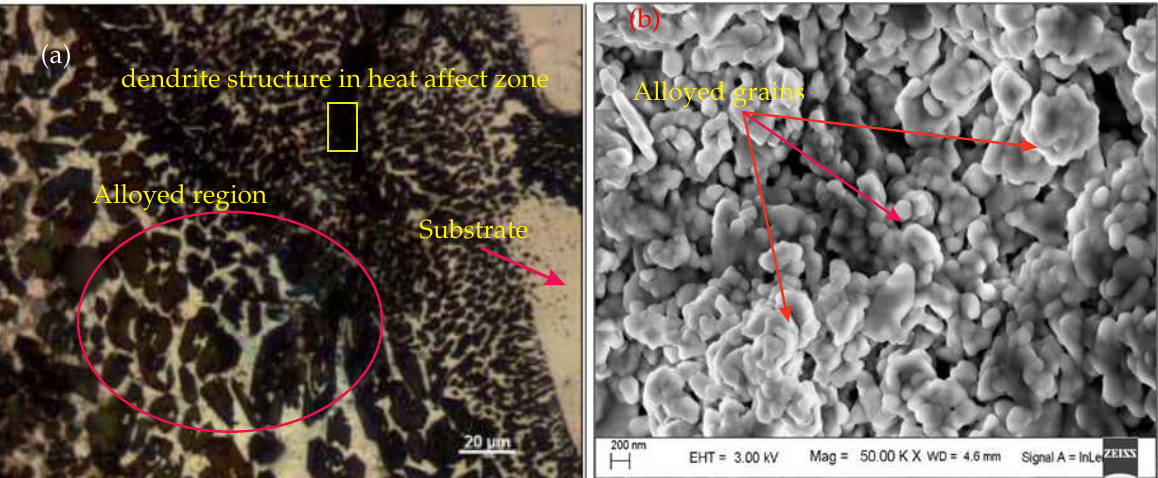
Figure 5. Microstructure of alloyed region image (20X) at laser surface alloyed samples at a laser beam spot diameter of 5.8 mm, scan speed of 5 mm/s and laser power of 1700 W. (a) Optical image, (b) FESEM analyzed results (image)